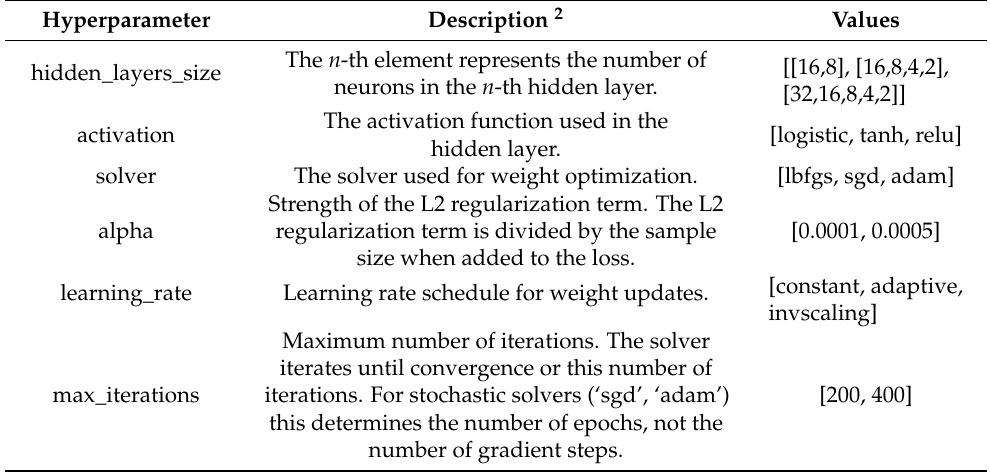
Table 3. hyperparameters used for training the Neural Networks and the different values considered.